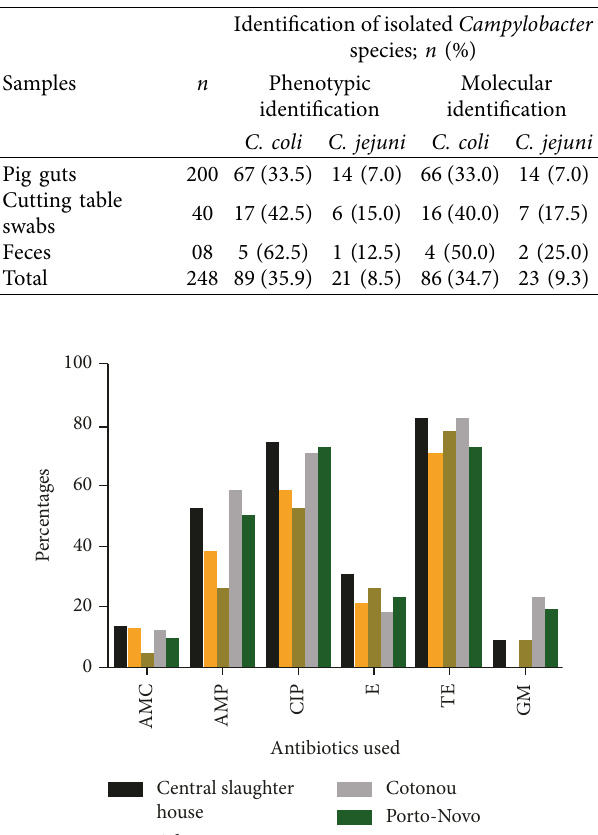
Sampling locations